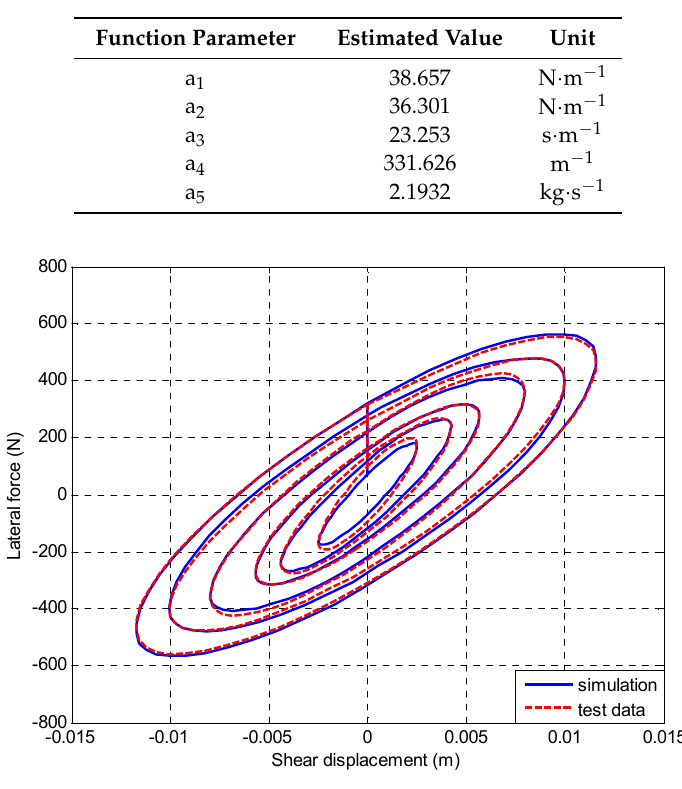
Figure 4. Experimental and numerical hysteresis loops at excitation frequency of 2 Hz.